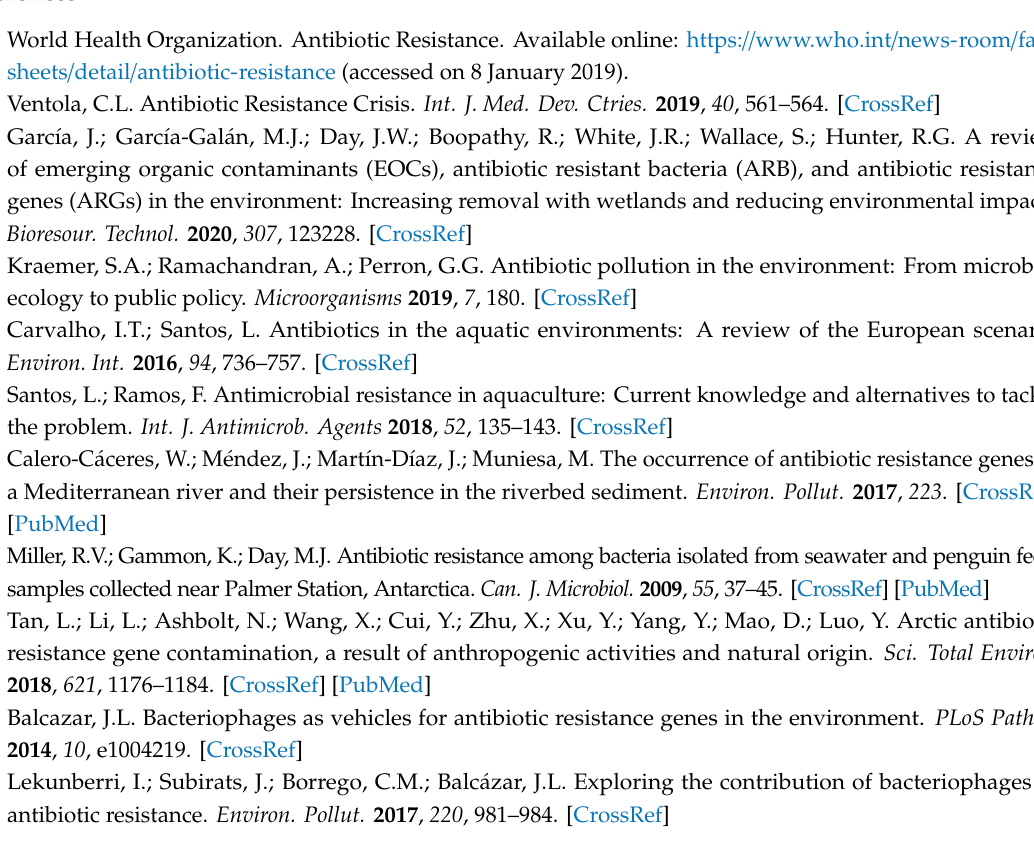
Figure S1: Abundance of ARGs in the DNA isolated from phage particles in fish and shellfish grouped by fish matrix. Table S1: Oligonucleotides used in this study